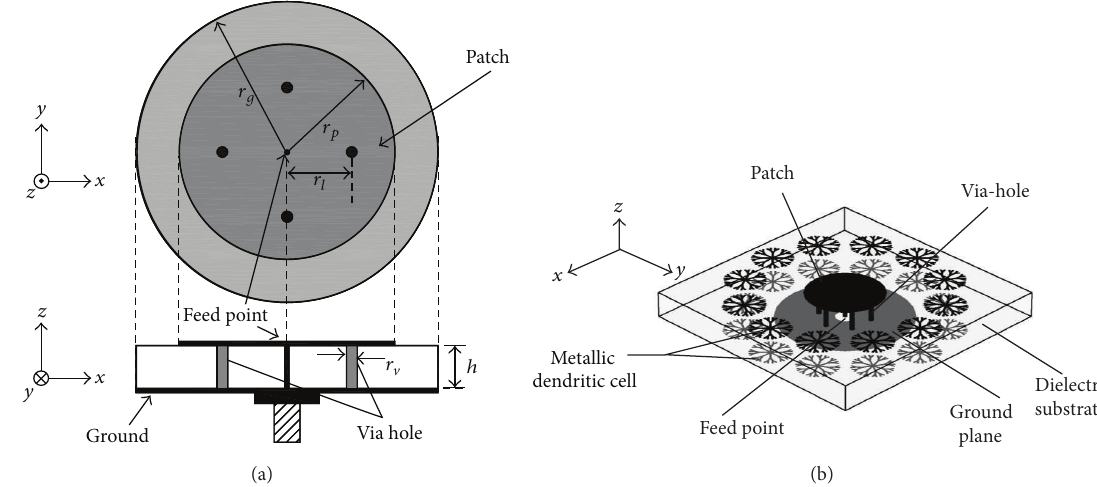
Figure 3: Antenna configurations. (a) Top view and side view of center-fed circular ENG ZOR antenna, (b) 3D view of center-fed circular ENG ZOR antenna with NPM. The center point of antenna is defined as the origin of coordinates.